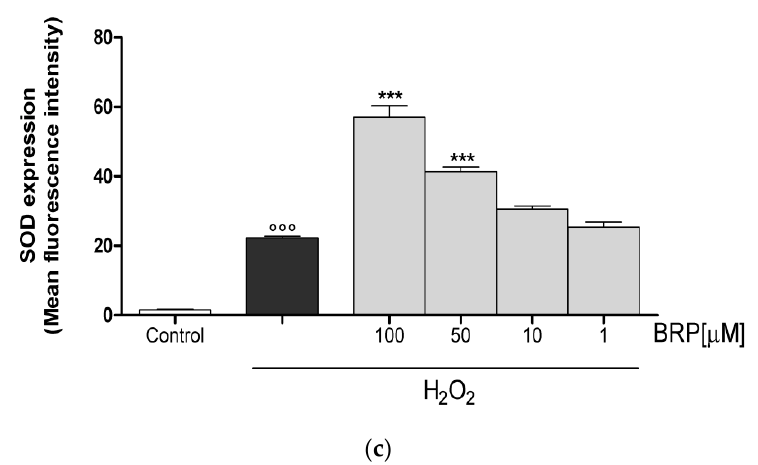
Figure 5. ( a ) Effect on HO-1, ( b ) NQO1, and ( c ) SOD expression of BRP in the IEC-6 cells, evaluated by cytofluorimetric technique. Values, mean ± s.e.m., are expressed as the % of inhibition of HO-1, NQO1, and SOD expression vs. H 2 O 2 alone-treated cells. *** and * denote p < 0.001 and p < 0.05 vs. H 2 O 2 . °°° denotes p < 0.001 vs. control.